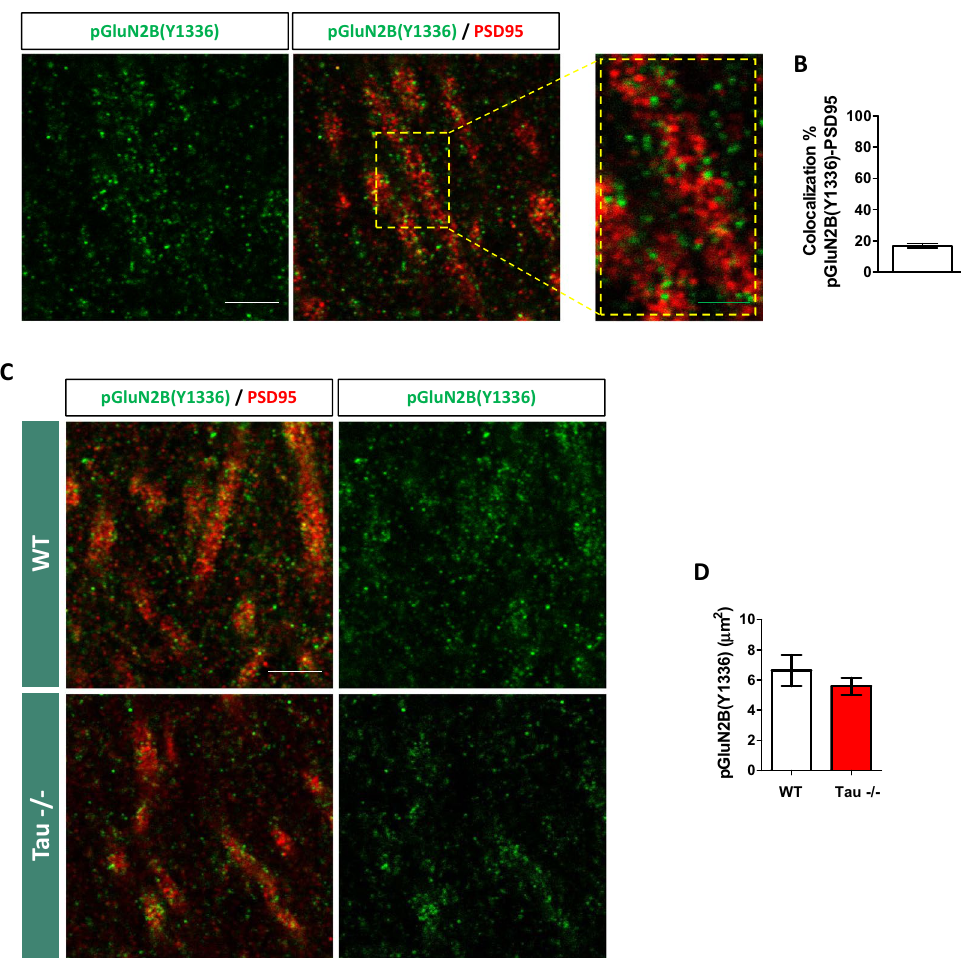
Figure 3. The distribution of GluN2B phosphorylated at Y1336, a post-translational modification occurring mainly at extrasynaptic sites, is not affected in the CA1 region of Tau − / − mice. ( A ) Representative image of CA1 hippocampal region of a WT mouse labeled with pGluN2B(Y1336) (green channel) and PSD95 (red channel) antibodies, as well as a high-power magnification showing that pGluN2B(Y1336) labeling is located close to but not overlapping PSD95 labeling. ( B ) Quantification of the percentage of co-localization between pGluN2B(Y1336) and PSD95 in WT mice. ( C ) Representative images of WT and Tau − / − CA1 hippocampal regions labeled with pGluN2B(Y1336) (green channel) and PSD95 (red channel) antibodies. ( D ) Quantification of the area occupied by pGluN2B(Y1336). Tau absence does not alter the area occupied by pGluN2B(Y1336) in the CA1 region of the hippocampus. Graphs show mean ± SEM. N = 5 mice per genotype. White scale bar 5 µ m. Green scale bar 2 µ m. Brightness and contrast of representative confocal microscopy images shown in the figure were minimally adjusted in order to improve